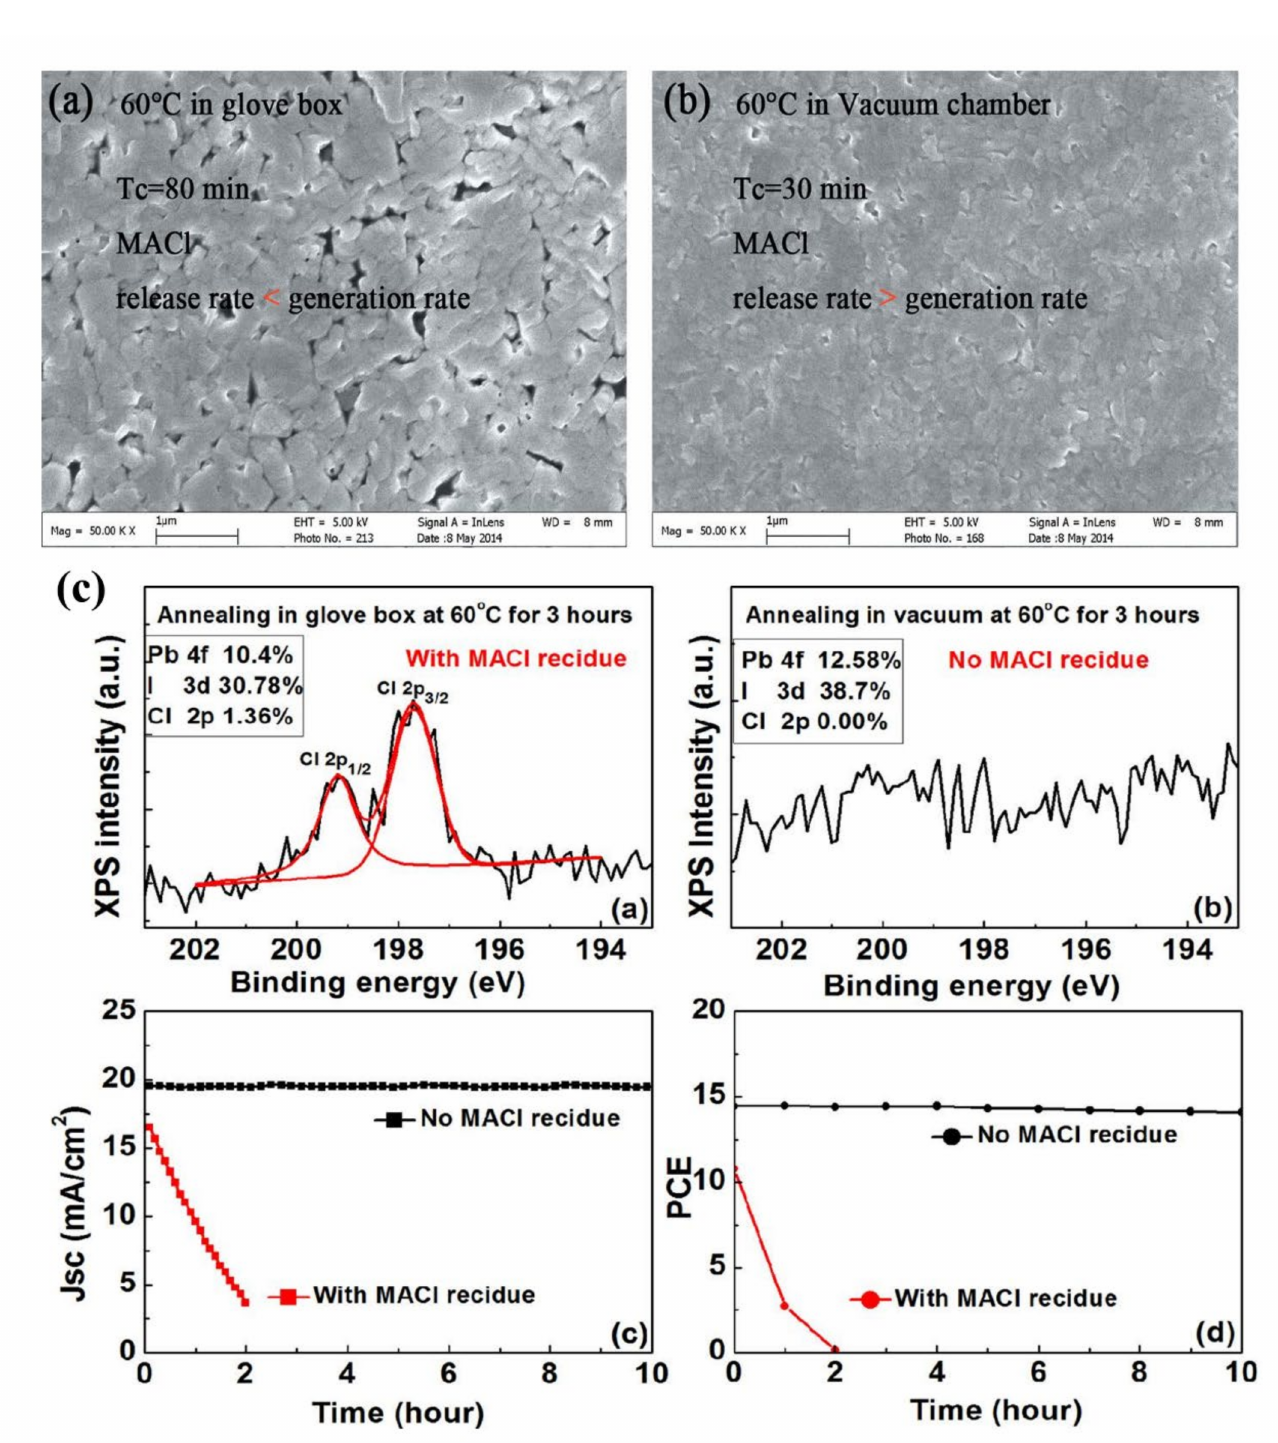
Figure 11. ( a ) SEM images of MAPbI 3 perovskite films treated by thermal annealing in a glovebox; ( b ) the vacuum chamber at 60 ◦ C; ( c ) XPS spectra of perovskite film annealing in a glovebox and vacuum, and the stability of perovskite photovoltaic devices in two annealing modes. Reprinted with permission from Ref. [7]. Copyright 2015 American Chemical